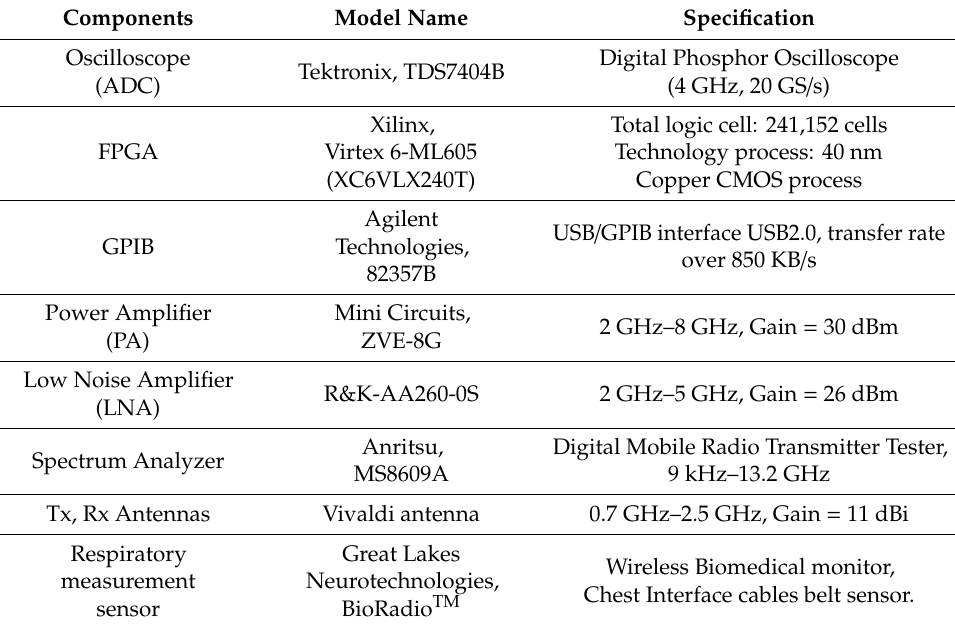
Table 2. The specifications of experimental